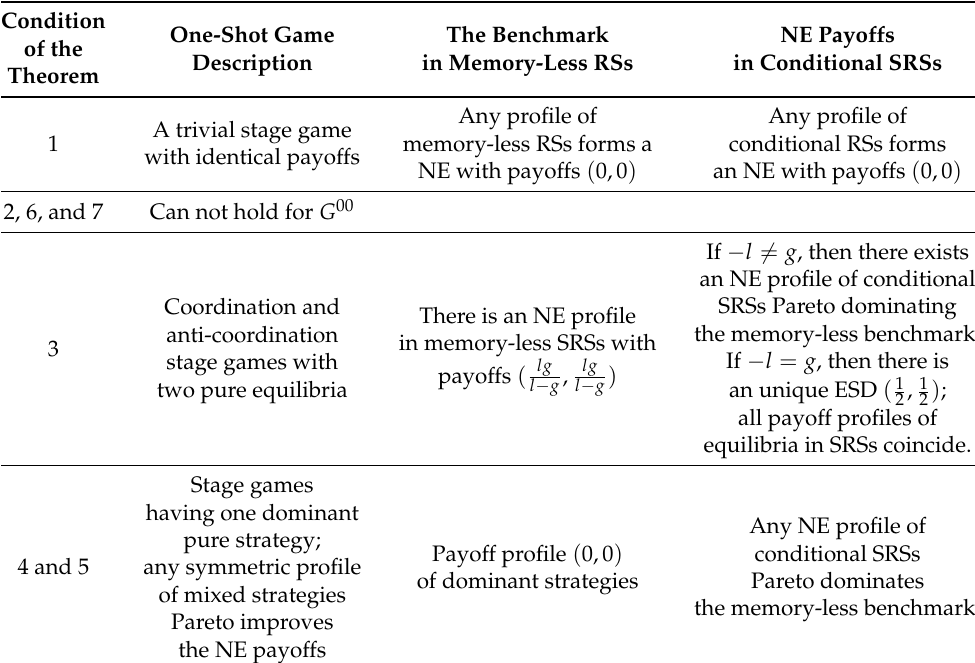
Table A1. Summary for Theorem 2 for symmetric games with equal payoffs on the leading